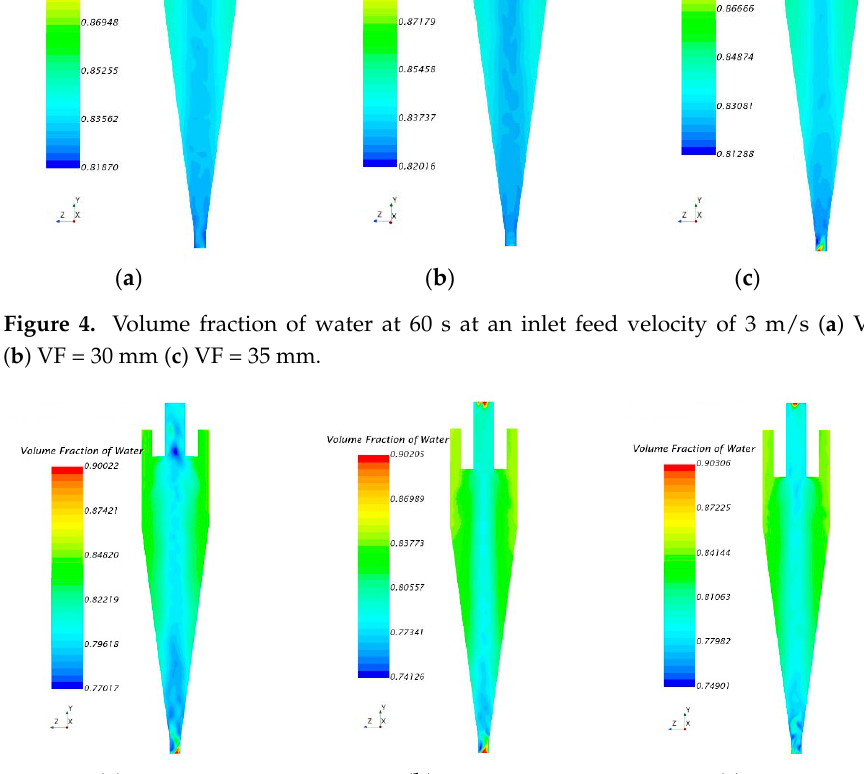
( c ) Figure 6. Volume fraction of water at 60 s at an inlet feed velocity of 10 m/s ( a ) VF = 20 mm ( b ) VF= 30 mm ( c ) VF = 35 mm. In terms of particles in a compound hydrocyclone, the finer particles flow where there is more water. It is seen in Figure 6c that there is a large volume of water in the outer vortex in the cylindrical section. It suggests increased centrifugal forces are pushing the finer particles and more water outward. This situation would favor coarser-heavier parti- cles inwardly but reduce the residence time of the particles in the hydrocyclone. They